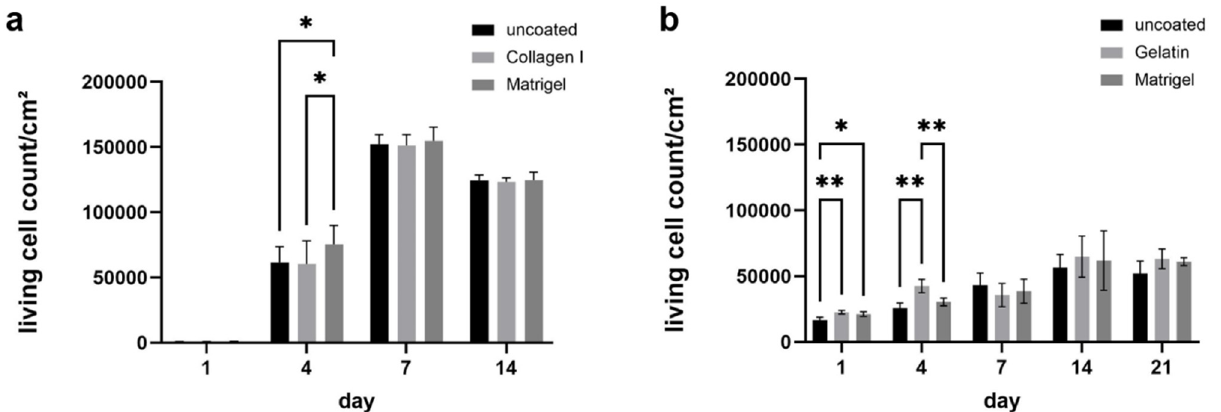
Figure 5. Seeding of 24-well of un- and coated PCL plates with ECFCs or pMSCs. Count of living cells/cm 2 of ( a ) ECFCs and ( b ) pMSCs. Results are expressed as mean + SD: * p < 0.05; ** p < 0.001 (Student’s t test).